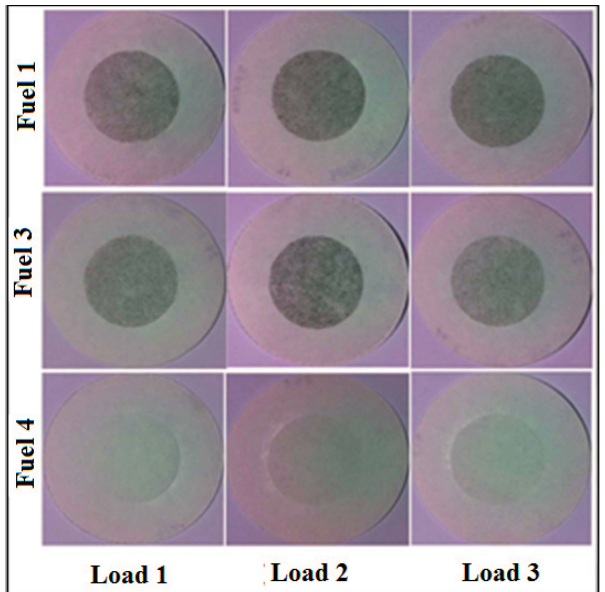
Figure 8. Actual Pictures of Whatman No 4 filter paper for